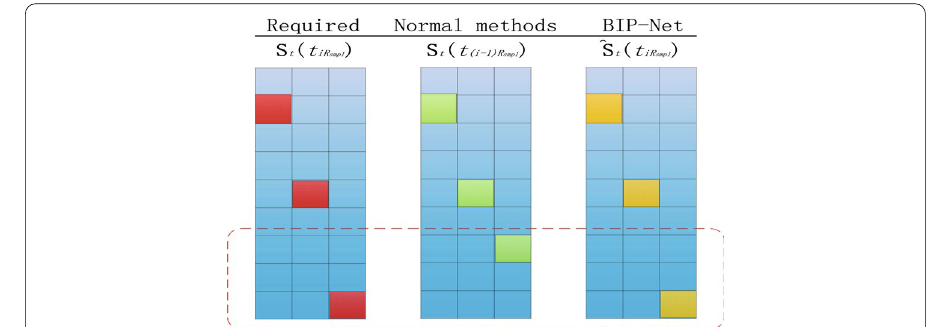
Fig. 14 Example of the performance of BIP-Net